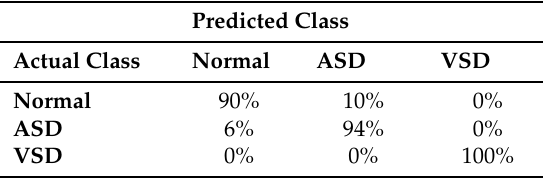
Table 7. Confusion matrix for multiclass experiments.